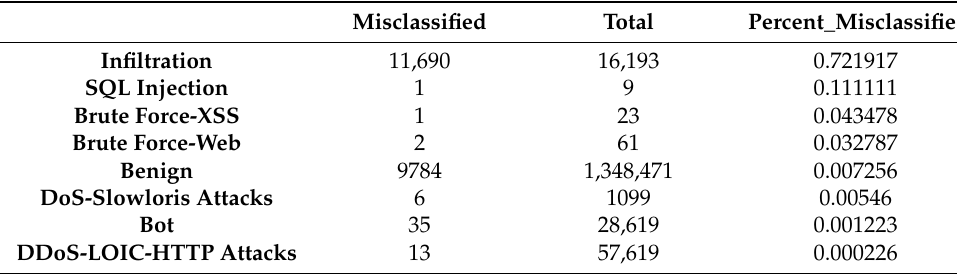
Table 10. Misclassification by attack